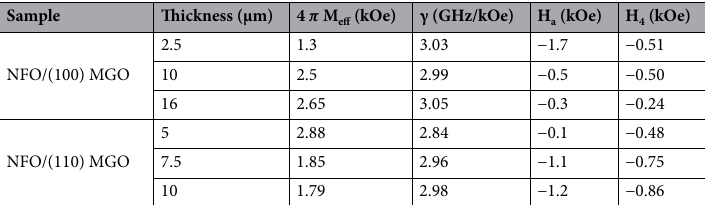
Table 4. The effective magnetization 4 π M eff , gyromagnetic ratio γ and the calculated uniaxial anisotropy field H a and magnetocrystalline anisotropy field H 4 determined from FMR profiles of NFO films on (100) and (110) MGO substrates.